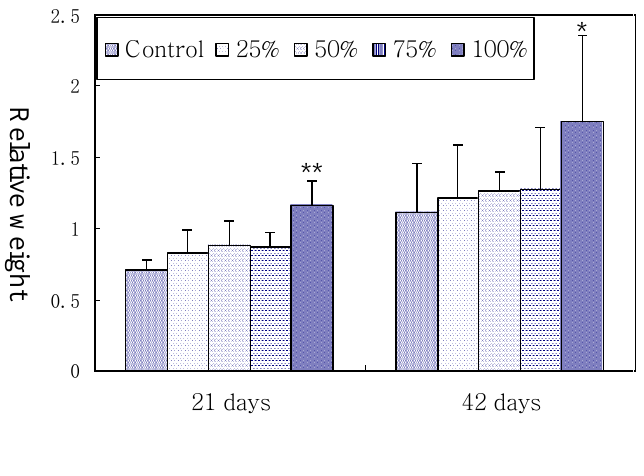
Figure 1. Effects of corn naturally contaminated with AFB1 and AFB2 on relative weight of broilers spleen. Data are presented with the means ± standard deviation ( n = 6). When compared with the control group, * means p < 0.05. ** means p <